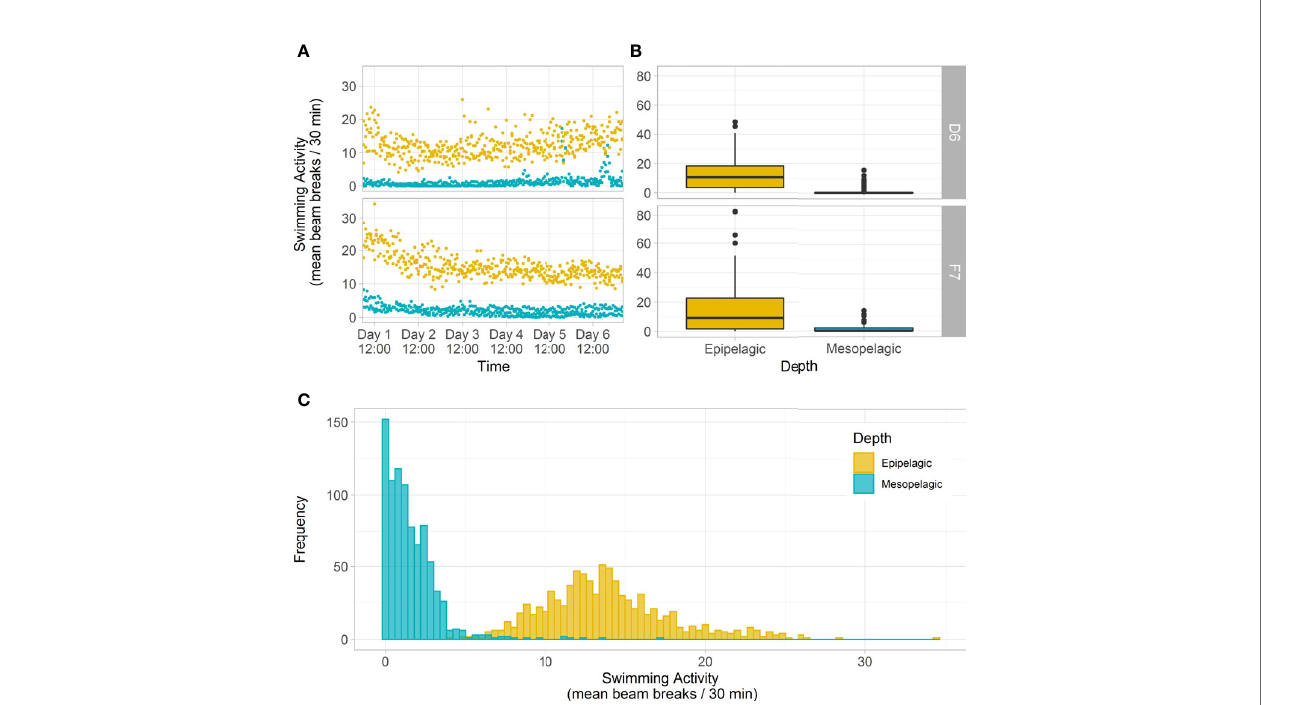
FIGURE 5 | Swimming activity (IR light beam breaks) of C. fi nmarchicus CV from epipelagic (yellow) and mesopelagic (blue-green) depths at slope station D6 and basin station F7, over 6 days in constant darkness. (A) Mean beam breaks recorded by each activity monitor (n=32 animals) at 30-minute intervals across the 6-day monitoring period. (B) Box plots of mean beam breaks per individual CV copepod per depth and station, averaged over 6-days (showing interquartile range around the median as the horizontal line, with black circles representing outliers). (C) Histogram showing the frequency of mean beam breaks recorded by each activity monitor (n=32 animals) at 30-minute intervals, pooled across both stations. There were slight differences in mesopelagic collection depths at the two stations: 375 – 500 m and 285 – 520 m at D6 and F7